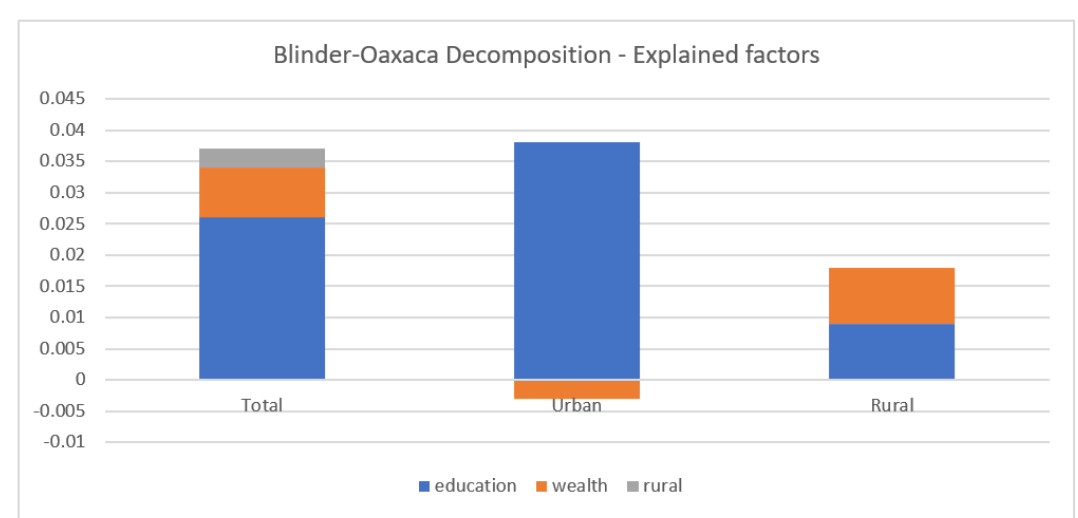
Figure 2. Blinder – Oaxaca decomposition for the change in the prevalence of zero-dose children over time. over